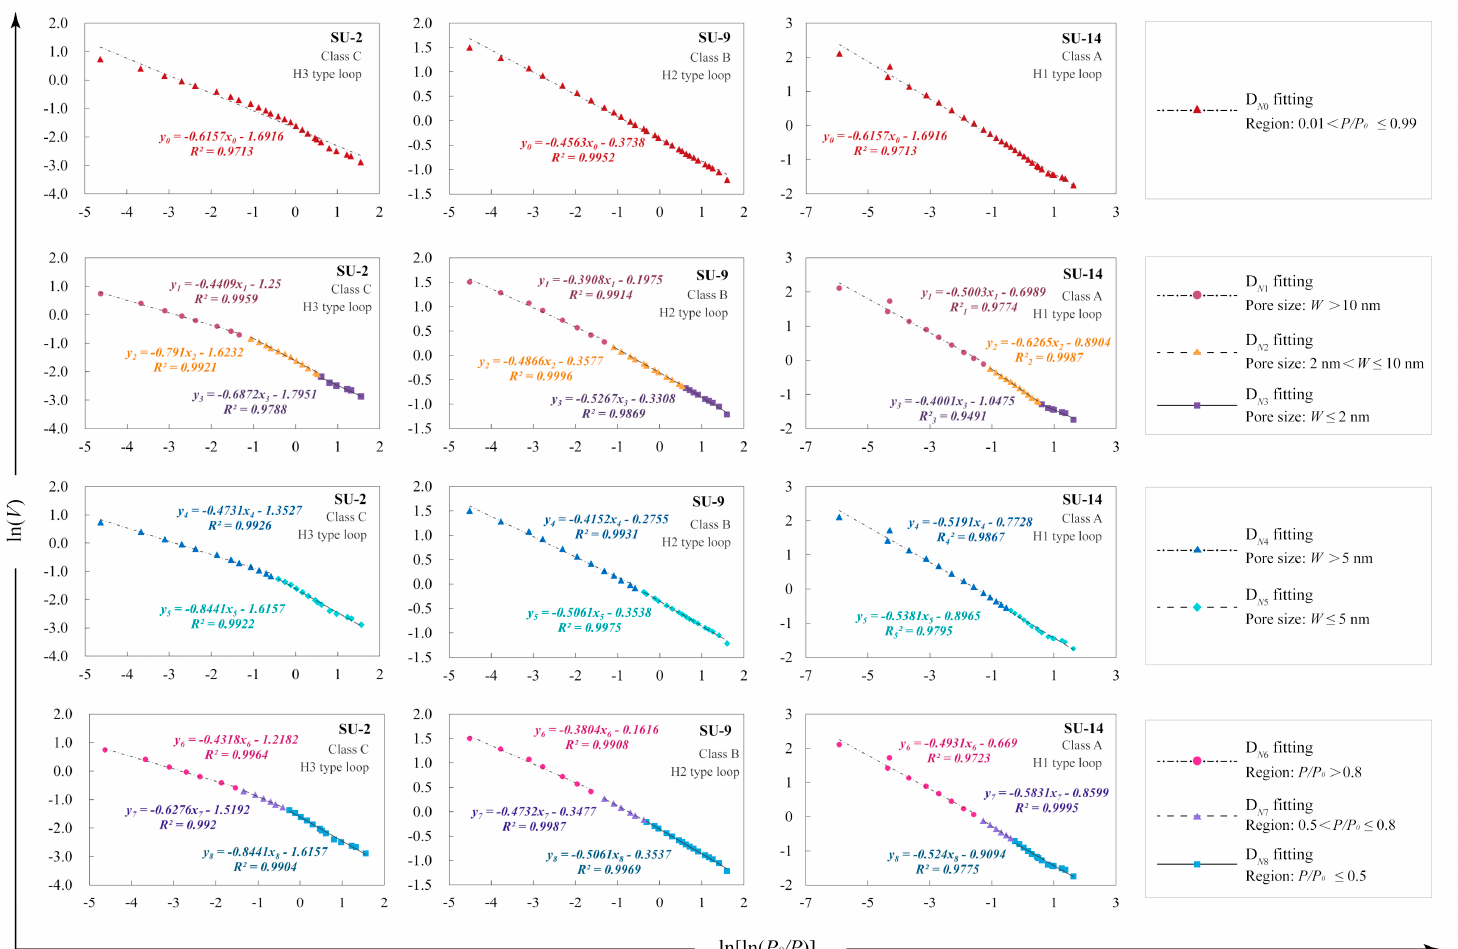
Figure 9. Representative plots of ln( V ) vs. ln[ln( P 0 /P )] reconstructed from the N 2 adsorption analysis of different class tight sandstone samples.